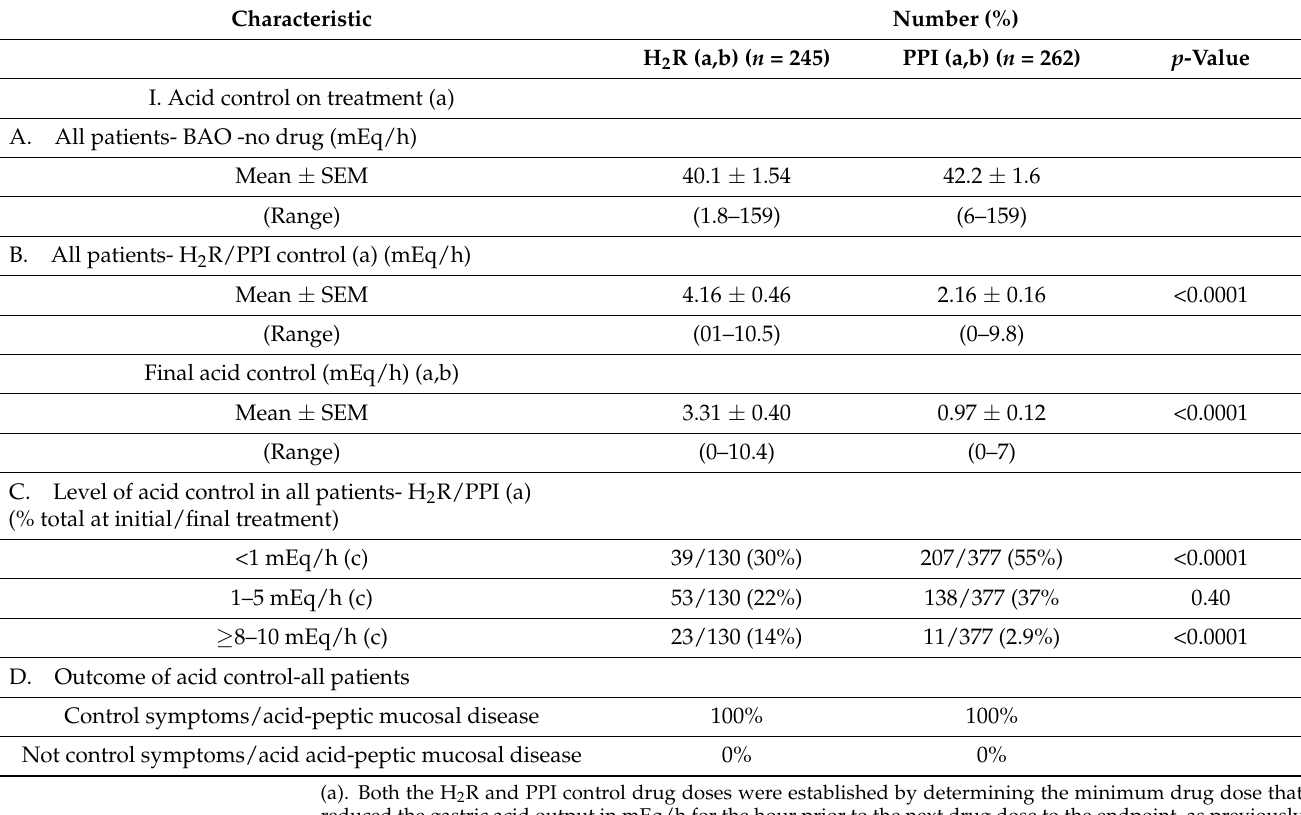
Table 6. Treatment outcomes-acid/symptoms.